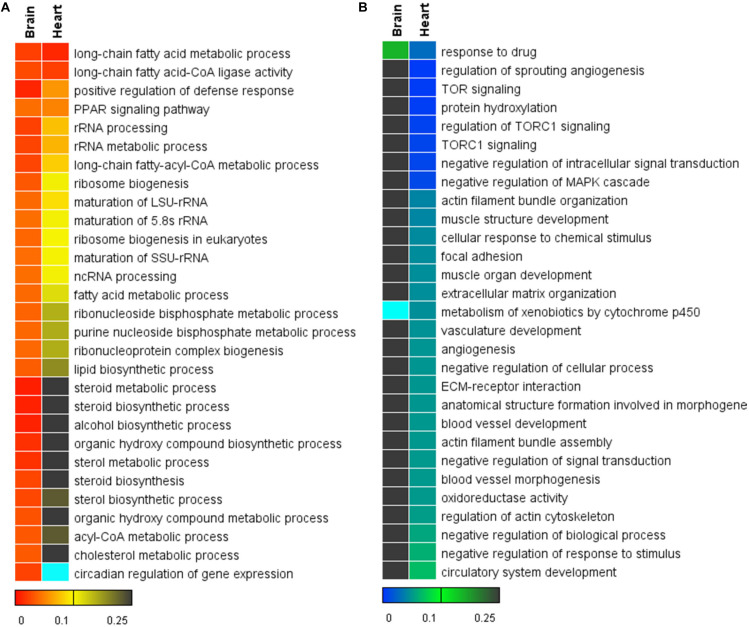
Heat maps for the top 30 functional gene sets enriched in the whole gene expression datasets. (A) Up-regulated gene sets. (B) Down-regulated gene sets. The color scales indicate the significance level of gene sets. The empty values are shown in cyan.